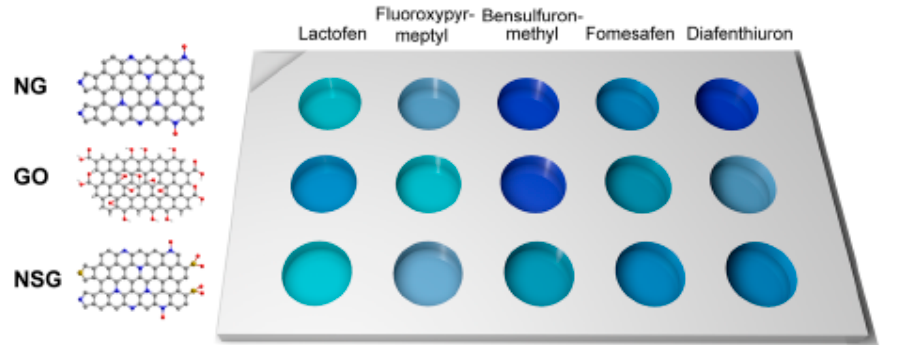
Figure 15. An array of peroxidase-mimicking graphene materials (graphene oxide (GO), nitrogen- doped graphene (NG) and sulphur-co-doped graphene (NSG)) used for the detection of five types of aromatic pesticides in the presence of TMB and H 2 O 2 . (Reprinted with permission from [139] . Copyright © 2020, American Chemical Society). Copyright © 2020, American Chemical